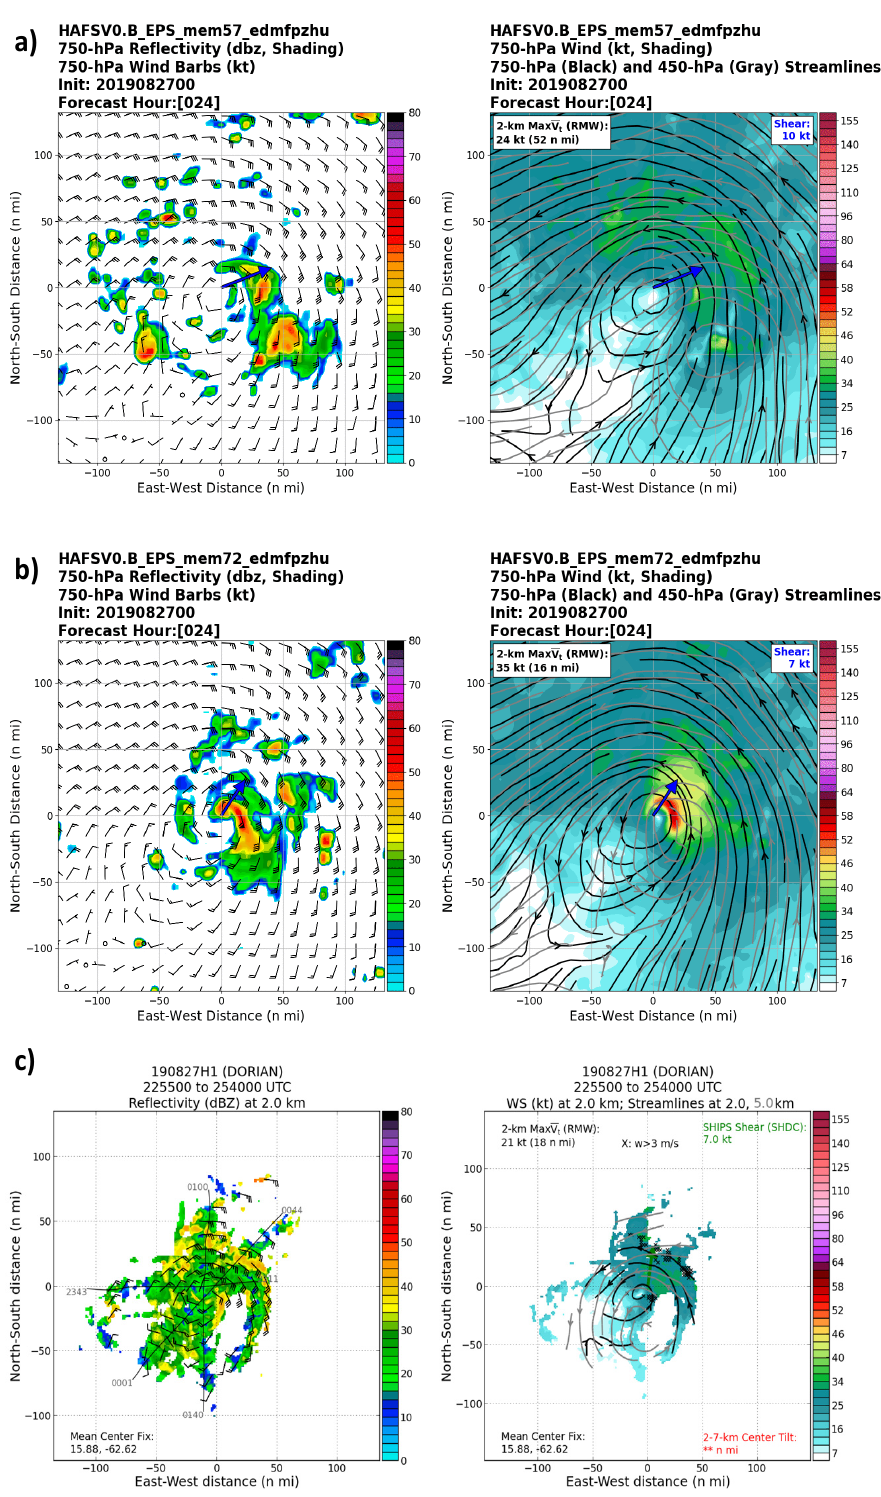
Figure 14. ( a ) Left: weak member (initialized 00 UTC 27 August 2019) 750-hPa reflectivity and wind barbs (kt, 1 kt = 0.51 m s − 1 ) at 24 h. Right: weak member 750-hPa wind (shaded, kt, 1 kt = 0.51 m s − 1 ), 750-hPa streamlines (black), 450-hPa streamlines (gray), and shear vector (blue) at 24 h. ( b ) As in ( a ), but for the strong member. ( c ) Left: NOAA WP-3D radar observations of 2-km reflectivity (dBZ) and wind barbs. Right: NOAA P-3 radar observations of 2-km wind (shaded, kt, 1 kt = 0.51 m s − 1 ), 2-km streamlines (black), 5-km streamlines (gray), and shear vector (green) for the flight period from 2225 UTC 27 August 2019 to 0140 UTC 28 August 2019.